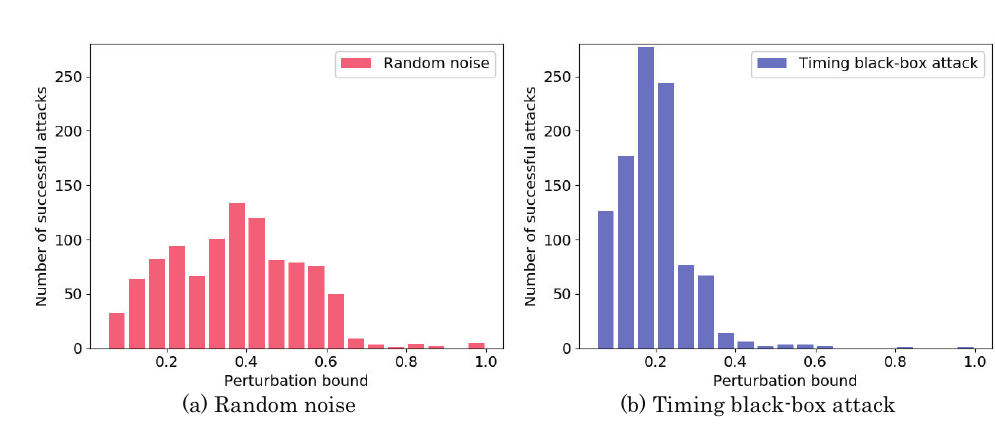
Figure 12: Histogram of successful attacks on 1,000 samples of MNIST dataset. Pro- posed attack is compared with random noise. Each perturbation bound is plotted when misclassification is caused by proposed attack and random